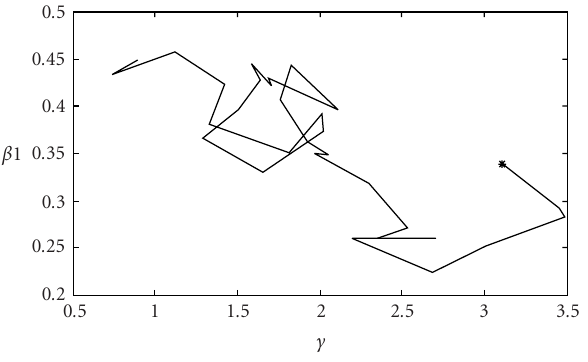
Figure 7: (a) MRF segmentation and (b) segmentation of the new